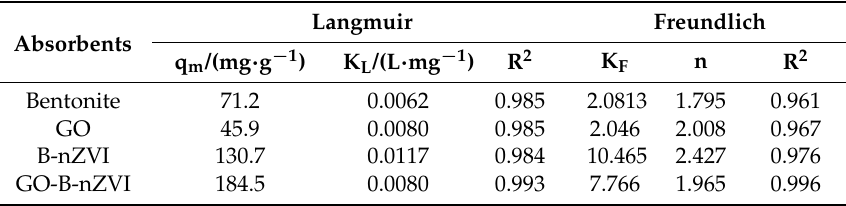
Table 4. Fit data of copper ions adsorbed by bentonite, GO, B-nZVI, and GO-B-nZVI by the Langmuir isothermal equation and Freundlich isothermal equation.